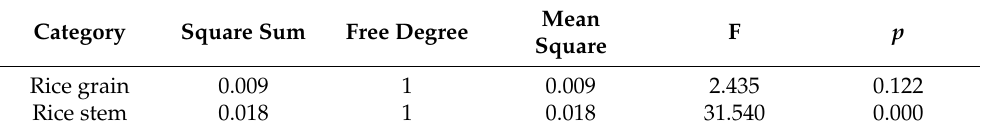
Table 6. ANOVA results for testing the effects of different configurations of the rice grains and stems on the static friction